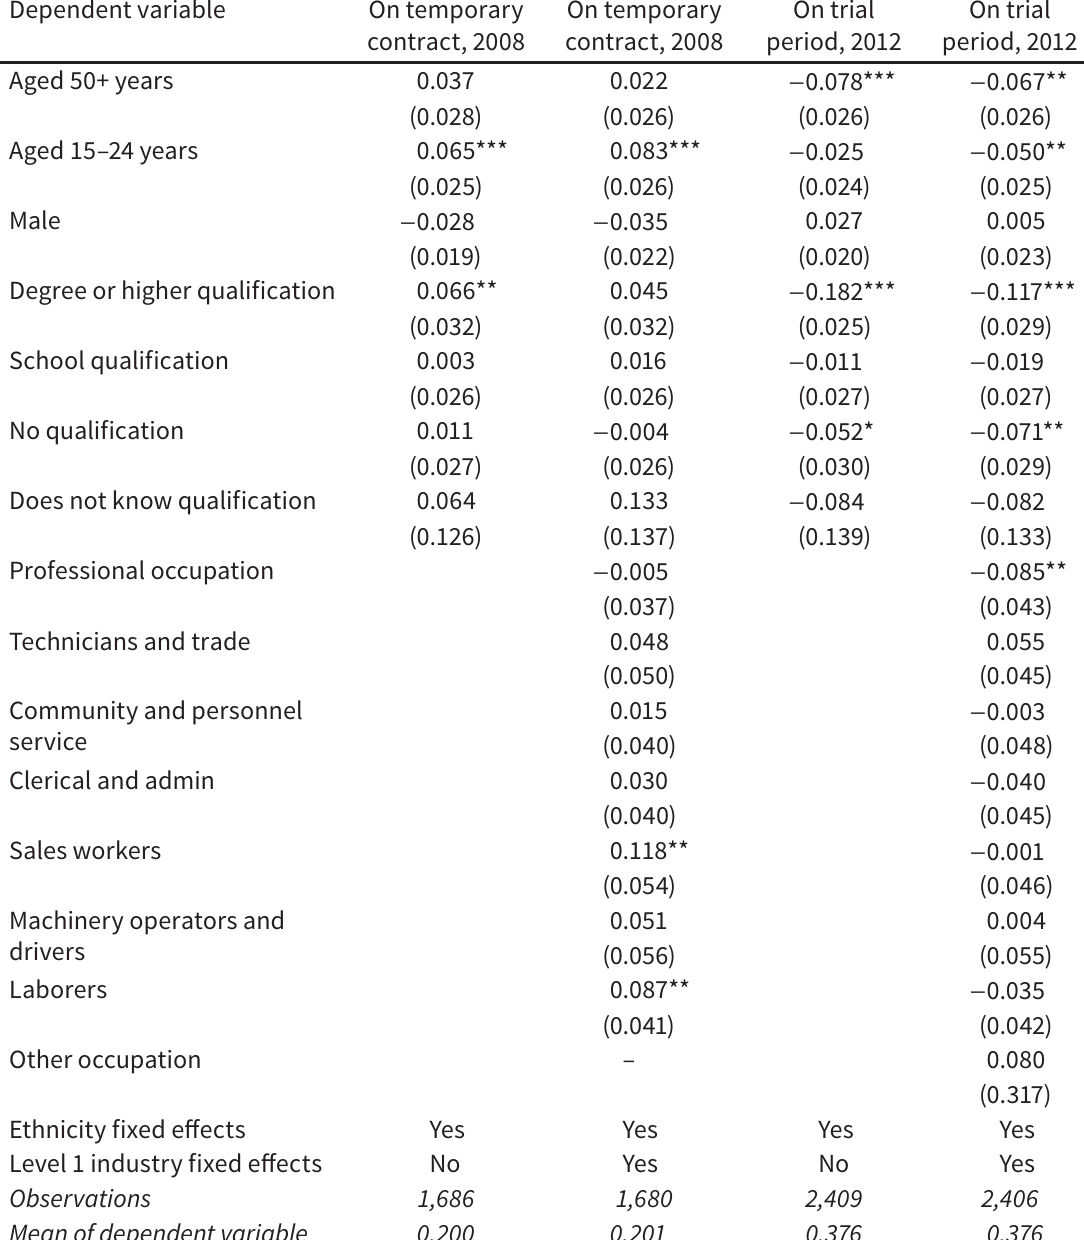
Table A8 Predicting temporary contracts and trial period